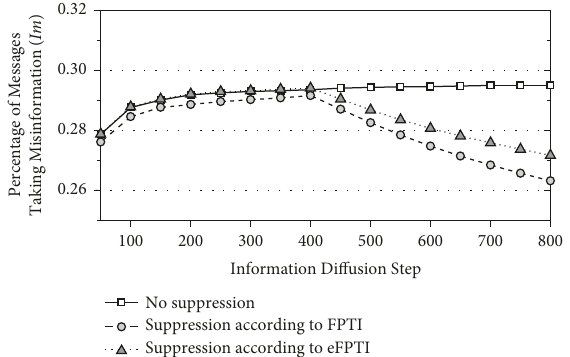
Figure 13: The effect of reputations of agents (generated by the proposed models) for suppressing the influence of malicious be- haviors (the suppression approach is implemented at the 400th execution